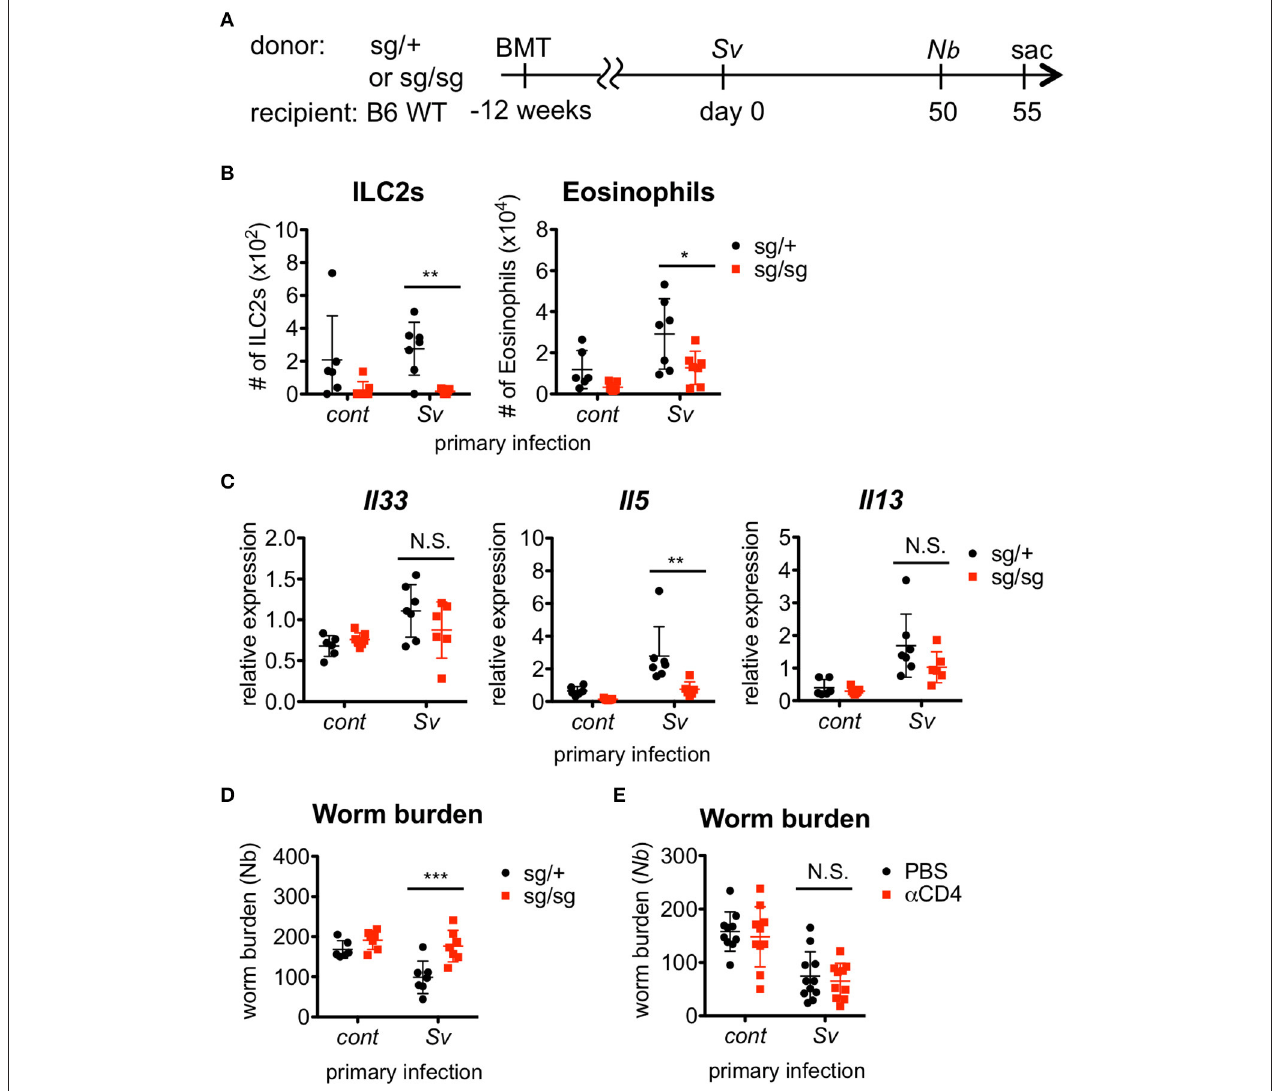
FIGURE 2 | ILC2s are critical for the enhanced inflammation and the protection against Nippostrongylus brasiliensis infection. (A) Experimental workflow for sequential nematode infection in bone marrow chimera mice. BMT; bone marrow transplantation, sac; sacrificed. S. venezuelensis -infected (Sv) or uninfected (cont) mice ( Rora sg / + , n = 6–7; Rora sg / sg , n = 7) were infected with N. brasiliensis (Nb). Five days after N. brasiliensis infection, (B) ILC2s and eosinophils among the BALF cells were analyzed by flow cytometry (LSRFortessa). Cell populations were defined as follows: ILC2s, FSC lo SSC lo CD45 + CD4 − Lin(CD3, CD8, CD19, NK1.1, IgE, siglec F, Gr-1) − Sca-1 + ST2 + and Eosinophils, CD45 + CD11c lo CD3 − B220 − CCR3 + . (C) Il33, Il5, and Il13 mRNA expression levels in the lungs were examined. (D) The numbers of worms in the intestine were counted at day 5 post- N. brasiliensis infection. Data are representative of two independent experiments. (E) S. venezuelensis -infected or uninfected WT mice were infected with N. brasiliensis after anti-CD4 Ab treatment ( α CD4) as in Figure S5 . The numbers of worms in